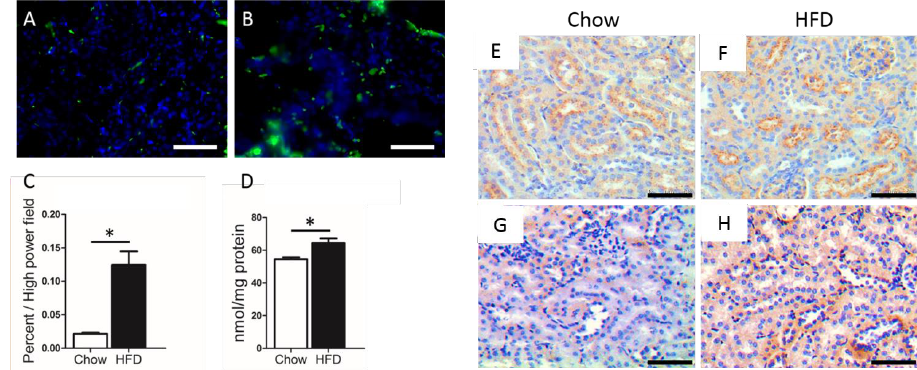
Figure 1. Representative images of BODIPY staining ( A and B ) in kidney sections from chow diet ( A ) and high fat diet (HFD) ( B ) mice. Scale bar = 50 μm. Analysis of BODIPY staining in different kidney sections ( C ). Total cholesterol content in the kidney from different groups ( D ). n = 6 mice/group, * p < 0.05. Representative images of immunostaining for FATP4 ( E and F ) and 4-HNE ( G and H ) in kidney sections from chow and HFD mice. Scale bar = 50 μm.